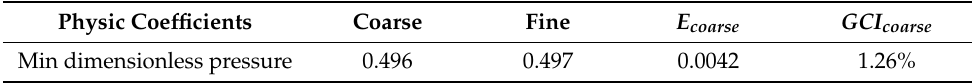
Table 4. Analysis of physic coefficients under different grid numbers.